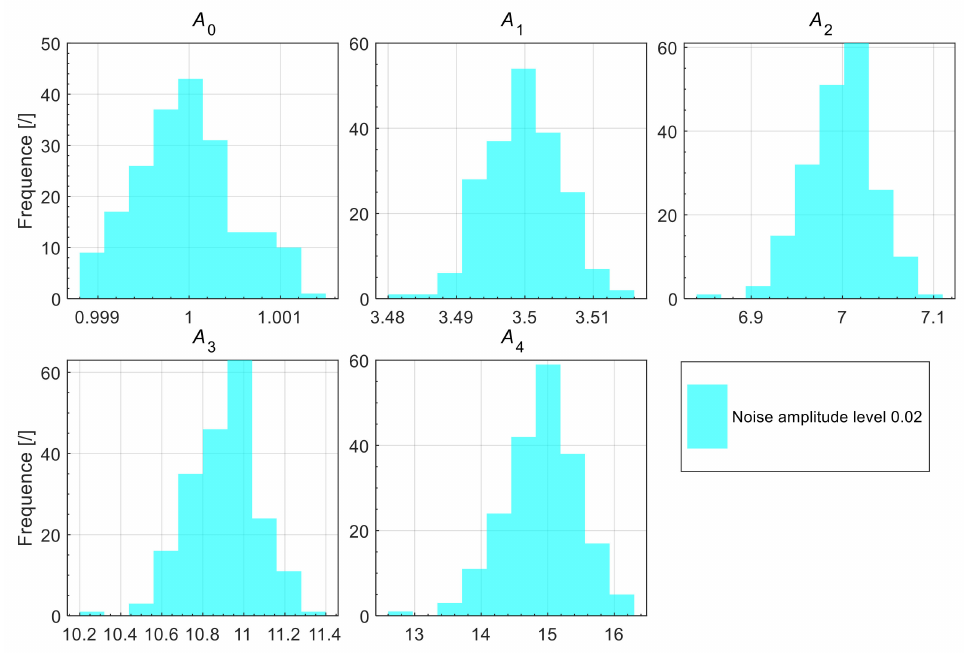
Figure 26. Histograms of the calculated characteristic